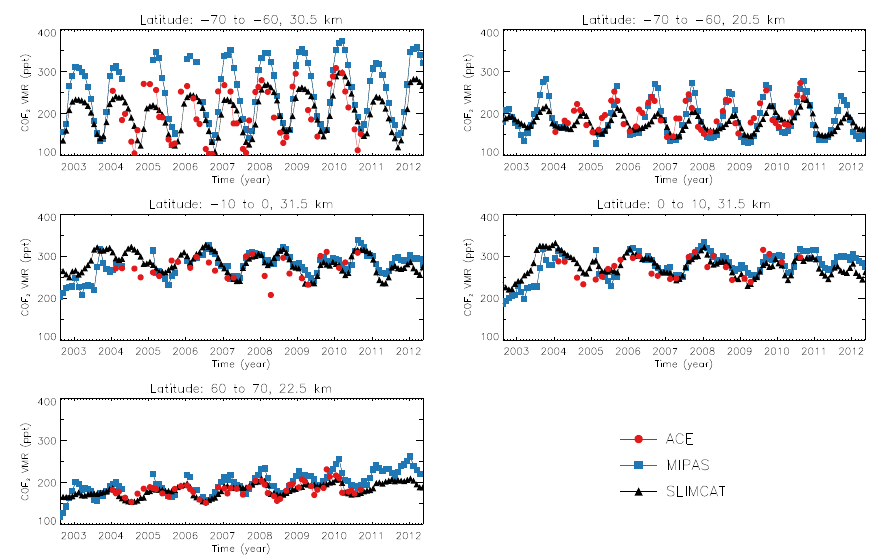
Figure 13. The ACE, MIPAS, and SLIMCAT COF 2 time series between July 2002 and April 2012 for five altitude–latitude bin combinations.